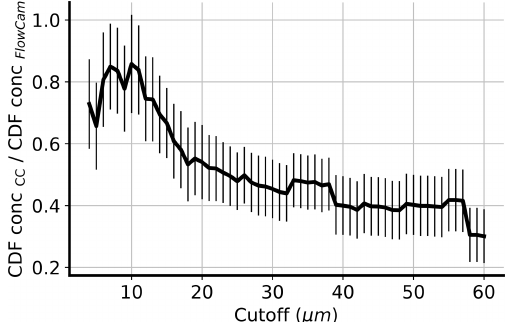
Figure 5. Mass concentration cumulative distribution function (CDF) ratios between the CC and the FlowCam as a function of a size cutoff. The best agreement is found at a cutoff value of